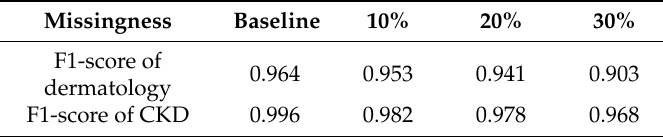
Table 5. Best results of the DRBM-based CF model for each